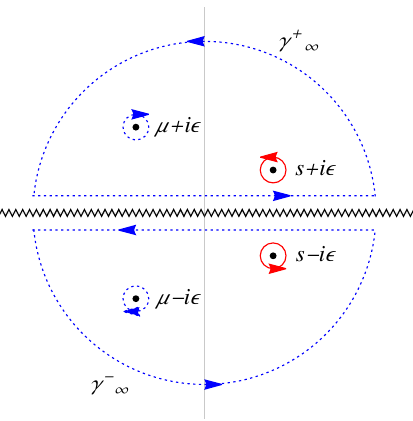
Figure 3 . Integration contours in the complex s -plane. The zigzag line corresponds to the branch cut. For points s ± i(cid:15) , the integration contour γ shown in red. The equivalent contours used in (4.12) are dotted in blue, including the subtraction of the point µ ± i(cid:15) . The radius of the semi-circumferences γ ±